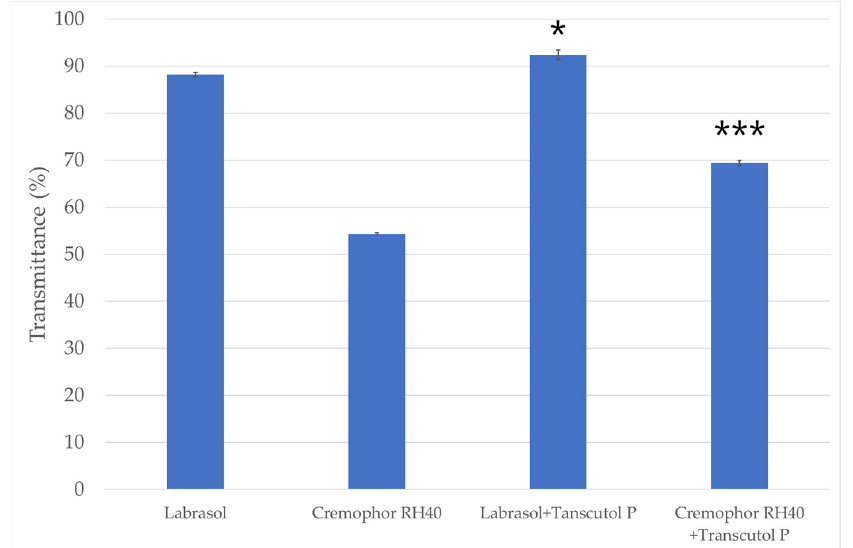
Figure 2. The emulsification efficiency of the surfactants and the mixture of surfactants and co-surfactant. Data are expressed as mean ± SD and n = 3. The usage of surfactants alone (Labrasol/Cremophor RH 40) was compared to the transmittance of the mixture containing co-surfactant (Transcutol P) with one-way ANOVA followed by Tukey’s multiple comparison test. Statistical significance is indicated *, *** at p < 0.005 and p < 0.001.